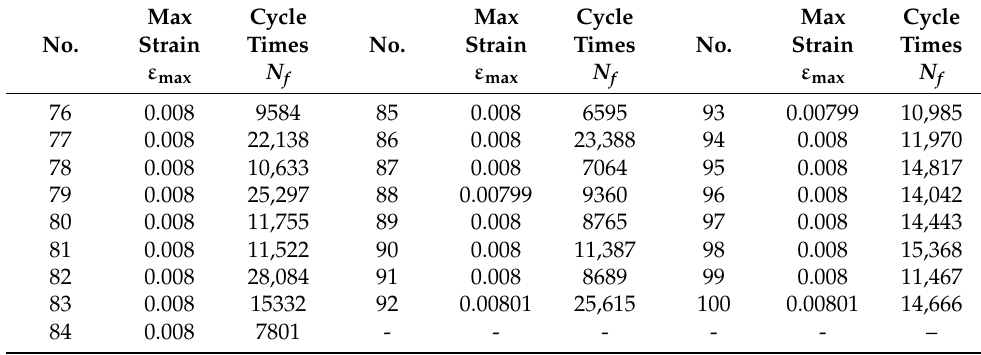
Table A3. Fatigue test data of T = 530 ◦ C, R = 0.05, strain range 0.76%.